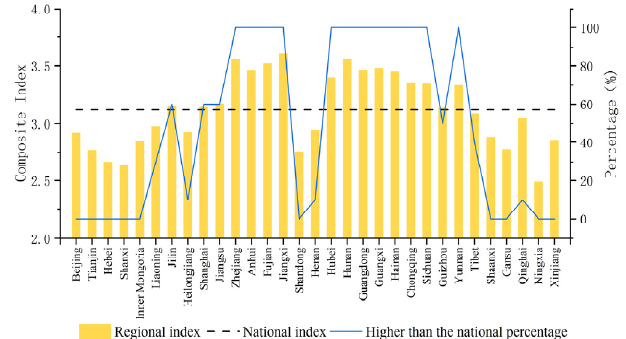
Figure 4. Statistics of collaborative security at provincial scale.